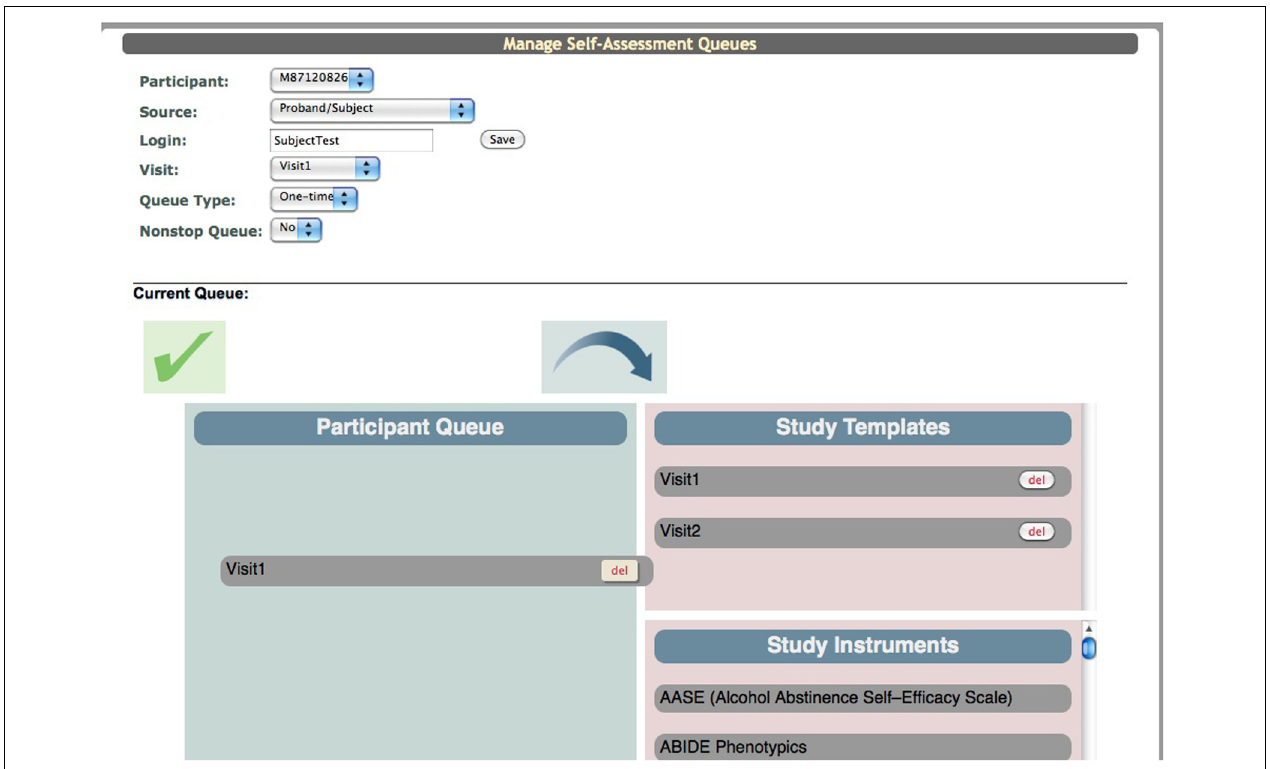
FIGURE 9 | Participant